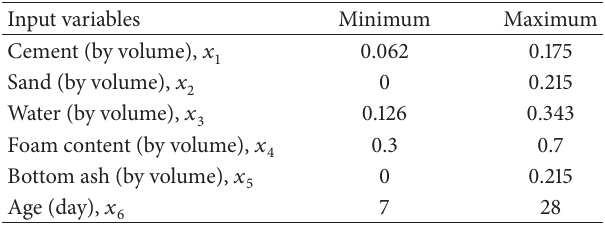
Table 5: The input variables used in nonlinear regression models.